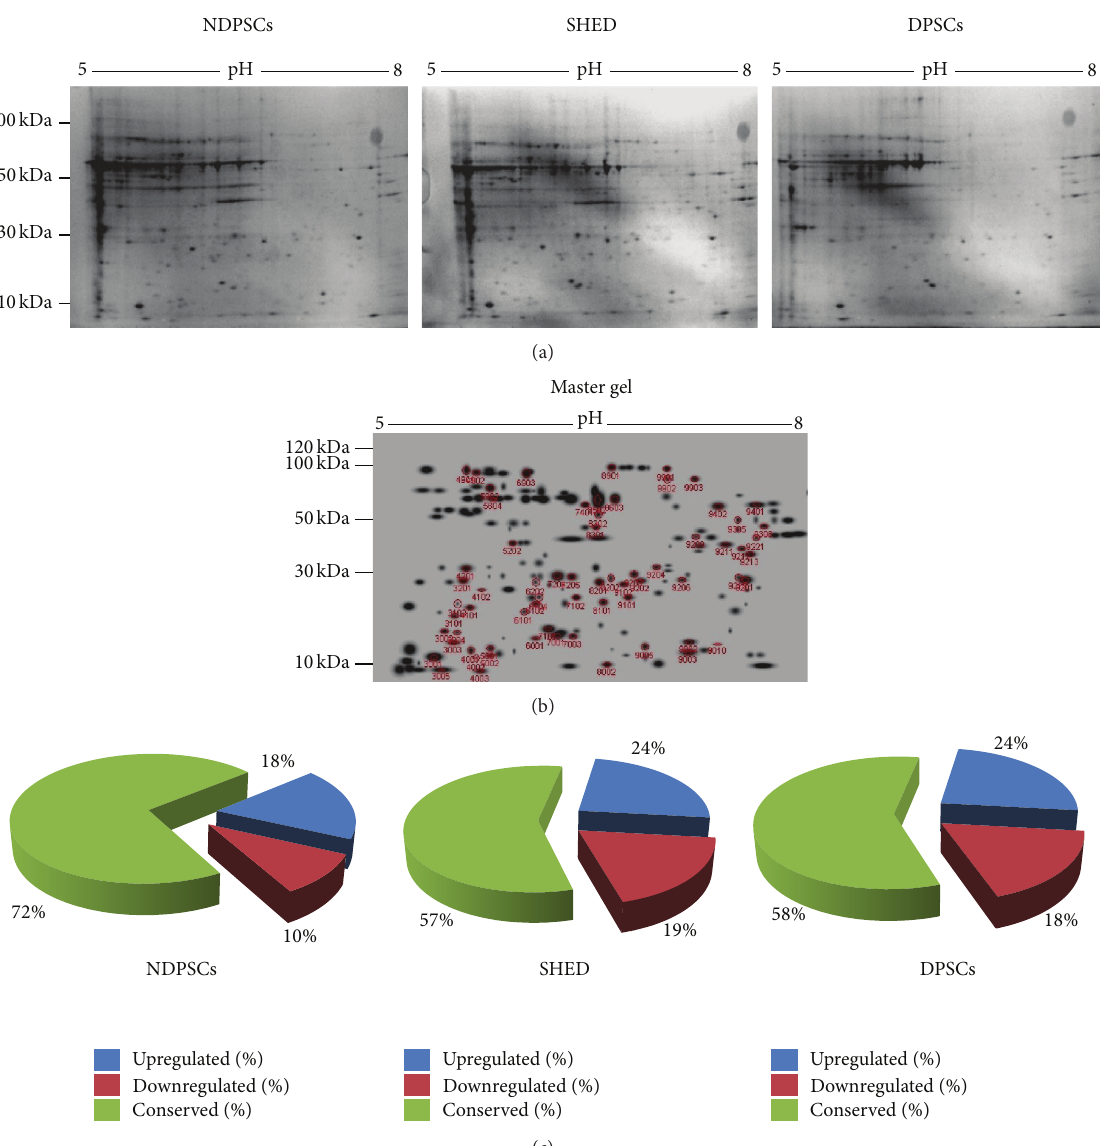
Figure 5: Comparative proteome analysis of NDPSCs, SHED, and DPSCs. (a) Undifferentiated MSCs were subjected to protein isolation and loaded onto pH 5 to pH 8 IPG strips for the first dimension and precast SDS-PAGE gels for the second dimension separation and stained with Colloidal Coomassie Blue for 24 hr after 24 hours of fixation. The gels are representative of three gels from each MSC type. (b) Master gel image was created by PDQuest Advance software to determine the number of spots that matched every member (183 spots). The numbers represent SSP numbers assigned to each spot by the software. These spots were cut from the gels and were subjected to MALDI-TOF/TOF analysis. Protein identification was performed by peptide mass finger printing by MASCOT (c) Pie charts to illustrate proteome conservation ratios among hNDP, SHED, and hDP-MSCs. Changes in spot intensities among 183 matching spots were compared. Spots that were up- or downregulated more than 2-fold were considered to be subjected to